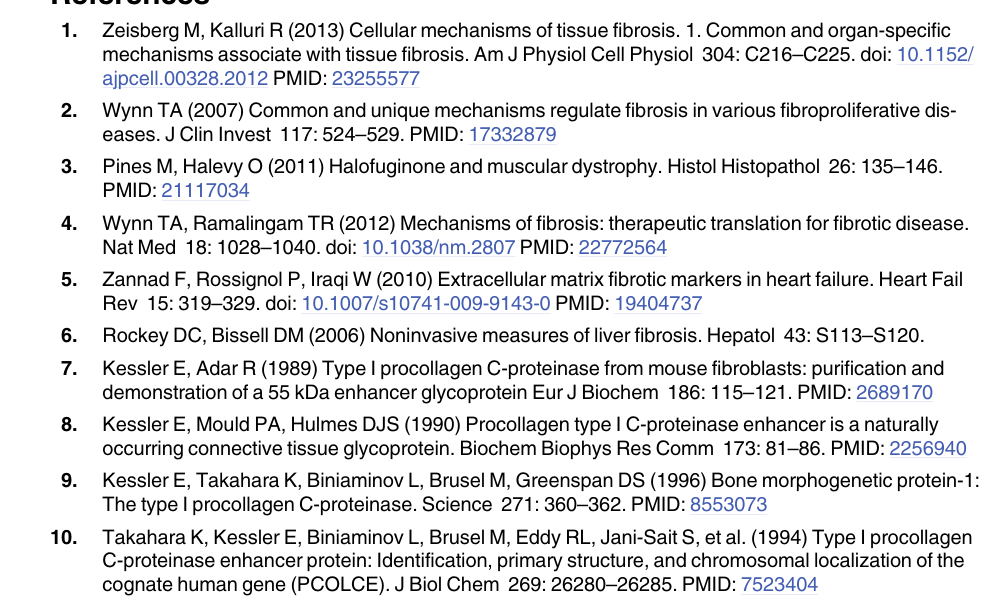
S1 Fig. SDS-PAGE analysis of the purified mPCPE-1 used as a standard for calculating PCPE-1 concentrations in the ELISA. S1 Table. Determination of inter-assay coefficient of variability for the mPCPE-1 sandwich ELISA. S2 Table. Determination of intra-assay coefficient of variability for the mPCPE-1 sandwich ELISA — the mdx model. S3 Table. Determination of intra-assay coefficient of variability for the mPCPE-1 sandwich liver fibrosis ELISA — the CCl 4